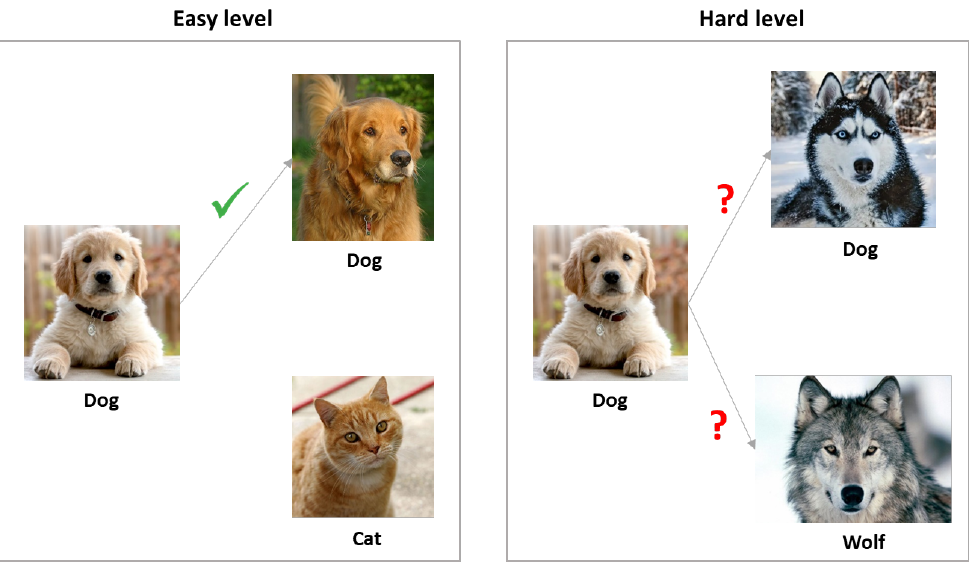
Figure 1. “Match the correct animal” by contrasting similar and dissimilar